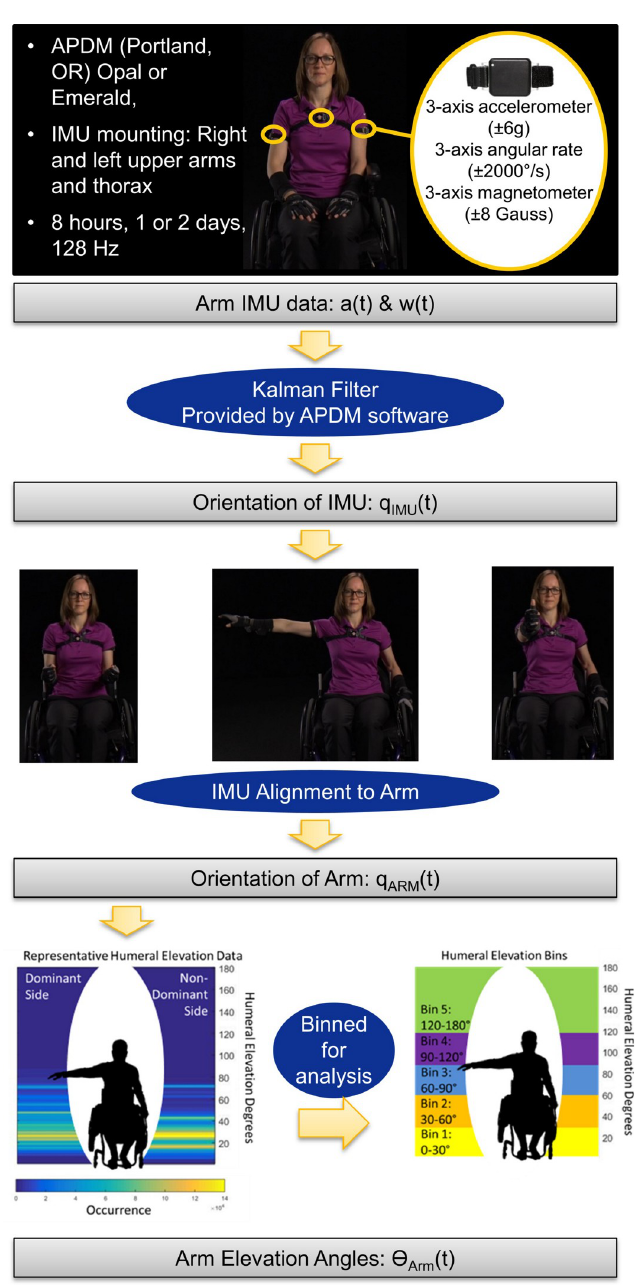
Fig 2. Data processing workflow. This included data collected, IMU orientation, IMU alignment to arm through calibration postures, representative data, and humeral elevation bins. The percentage of time spent in each bin was calculated and used for analysis. (Note: The individual pictured is a co-author who is able-bodied).